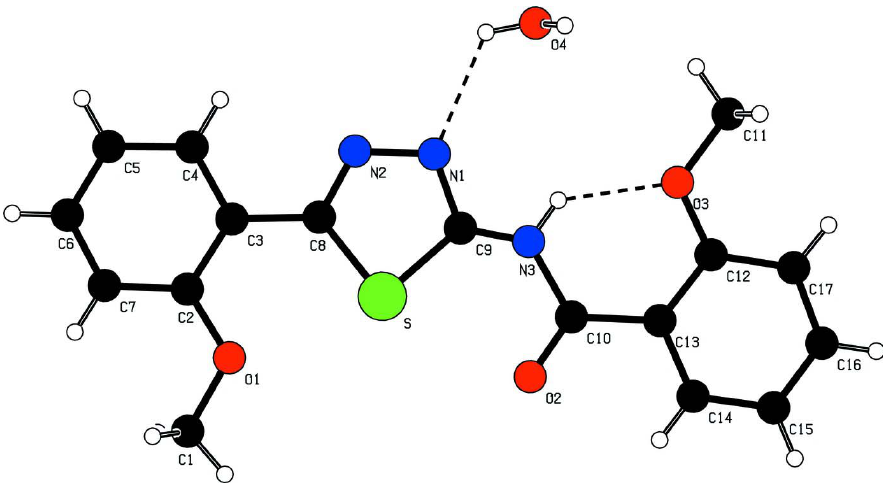
Figure 1 The molecular structure of the title molecule, with the atom-numbering scheme. Hydrogen bonds are shown as dashed lines.